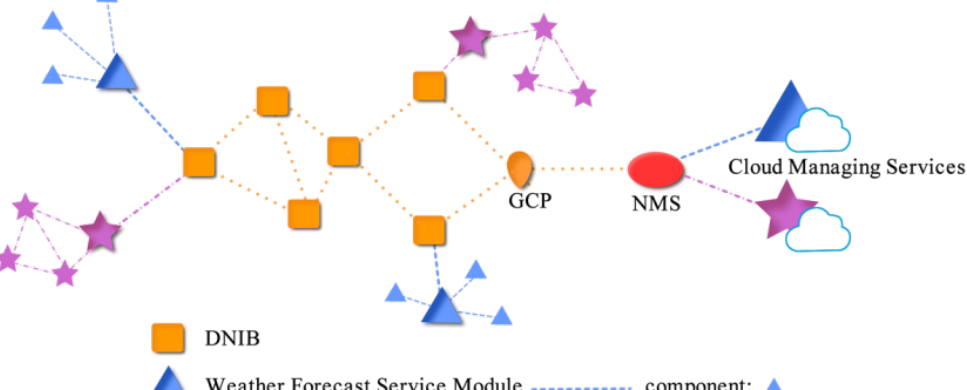
Figure 6. DNIHSS blocks.